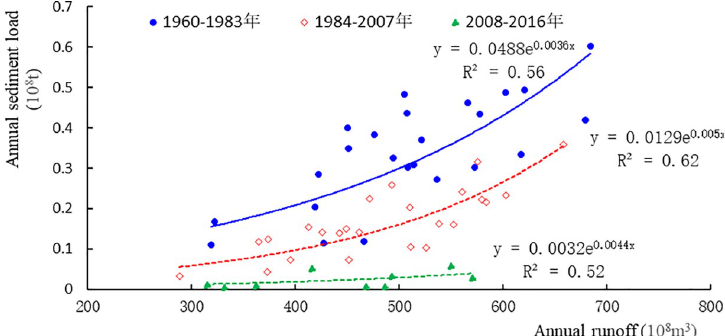
Fig 7. Runoff volume-Sediment discharge relation graph in various stages at Wu Long